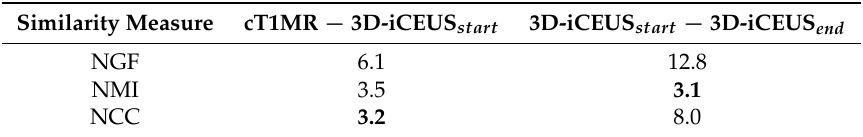
Table 3. Mean processing time in s during the registration computed for the successful cases (patient 10